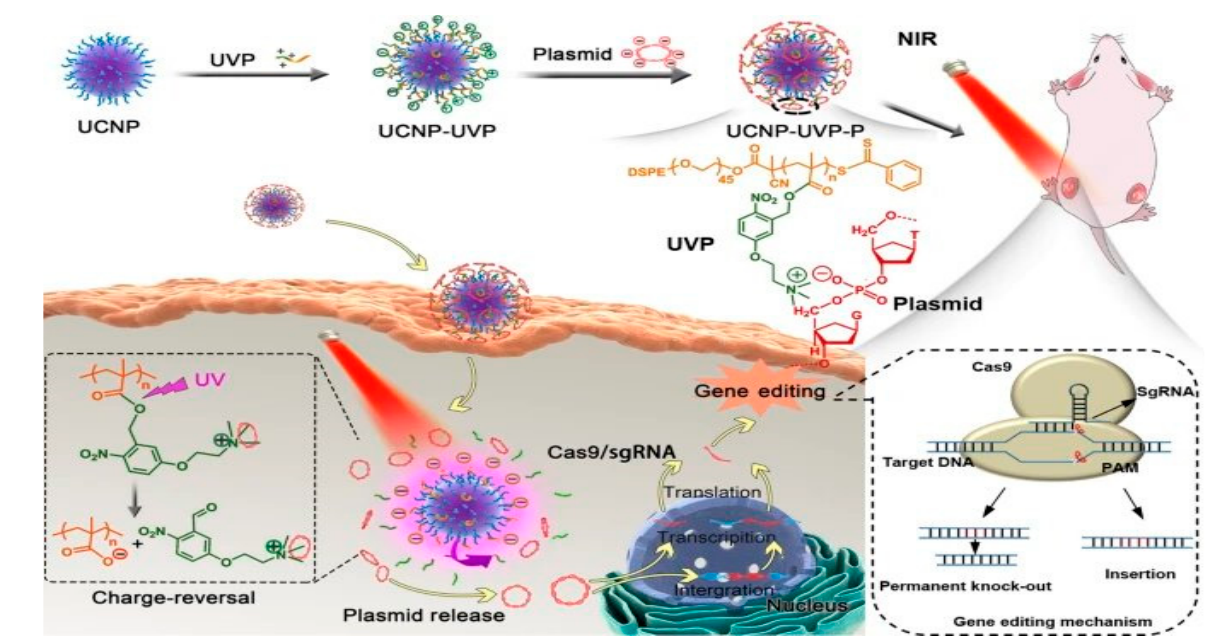
Figure 8. Schematic illustration of the synthesis of upconversion NPs with polyelectrolyte-coated (UNNP-UVP-P) and their usage in controlled delivery of CRISPR/Cas9 components. Reprinted with permission from ref [68]. Copyright 2020, Springer Nature.